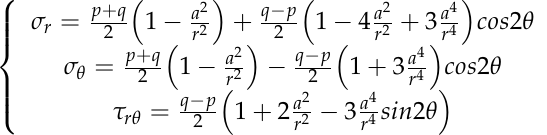
Figure 7. Concrete specimen failure state and cracks distribution after the experiment [20]: ( a ) Failure state and cracks distribution of D1 specimen; ( b ) Failure state and cracks distribution of D2 specimen; ( c ) Failure state and cracks distribution of D3 specimen; ( d ) Failure state and cracks distribution